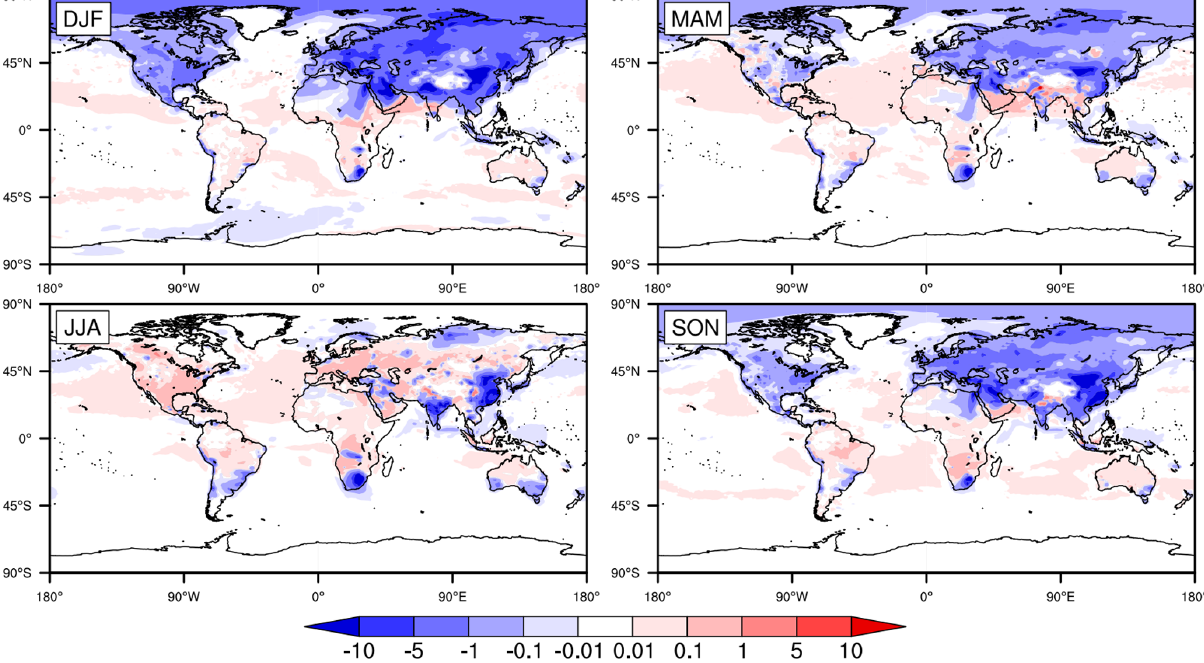
Figure 3. The differences in global seasonally averaged surface SO 2 mixing ratios between the improved case and the original case in 2015, after the incorporation of detailed in-cloud aqueous-phase chemical mechanisms